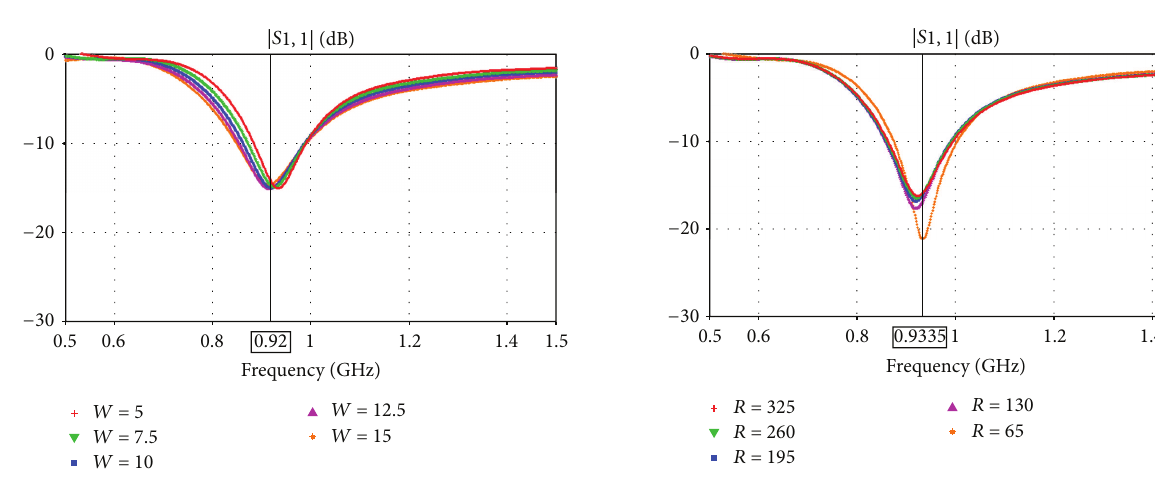
Figure 12: Resonance frequency of double-layers strip dipole antenna with difference curving radius (millimeters).